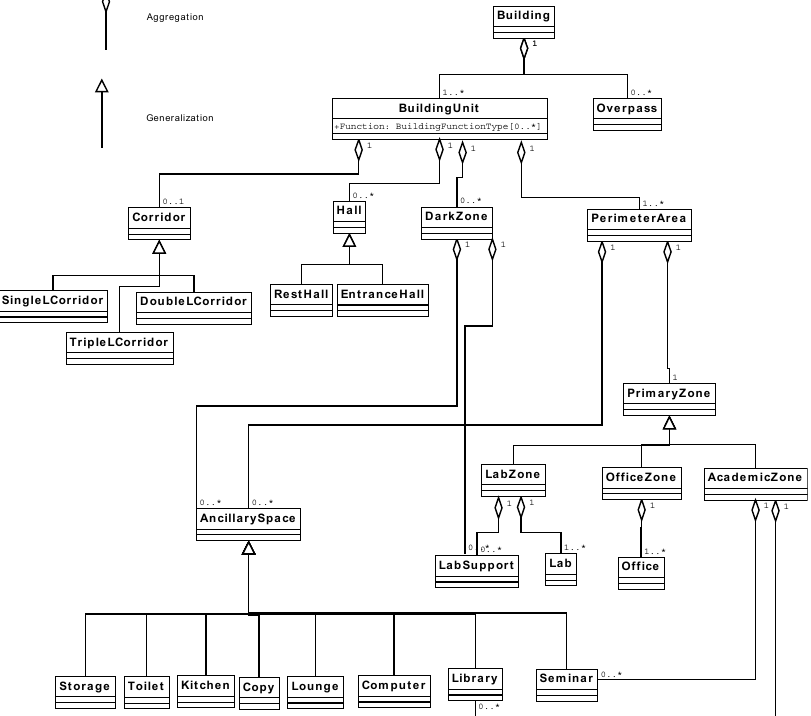
Figure 2. Semantic division of research buildings.